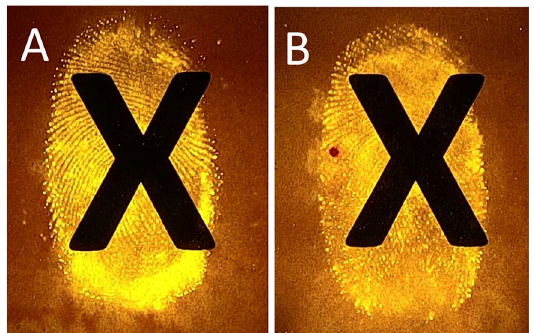
Figure 4. Fingermarks developed using DFO placed prior to printing an X ( A ) and on top of a printed X ( B ).